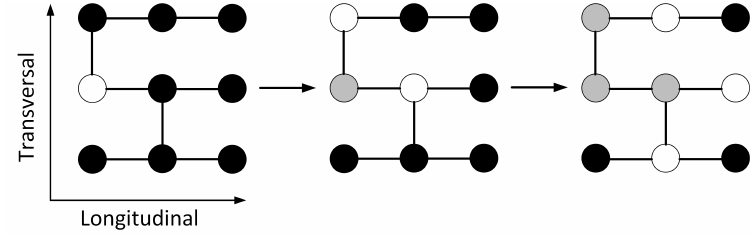
Figure 1. The diagram of interaction between cells within the network. Resting cells (black) and excited cells (white) interact in two directions with different probabilities. The resting cell becomes excited if it interacts with another excited cell. An excited cell (white) enters a refractory state (gray) for a time period τ .